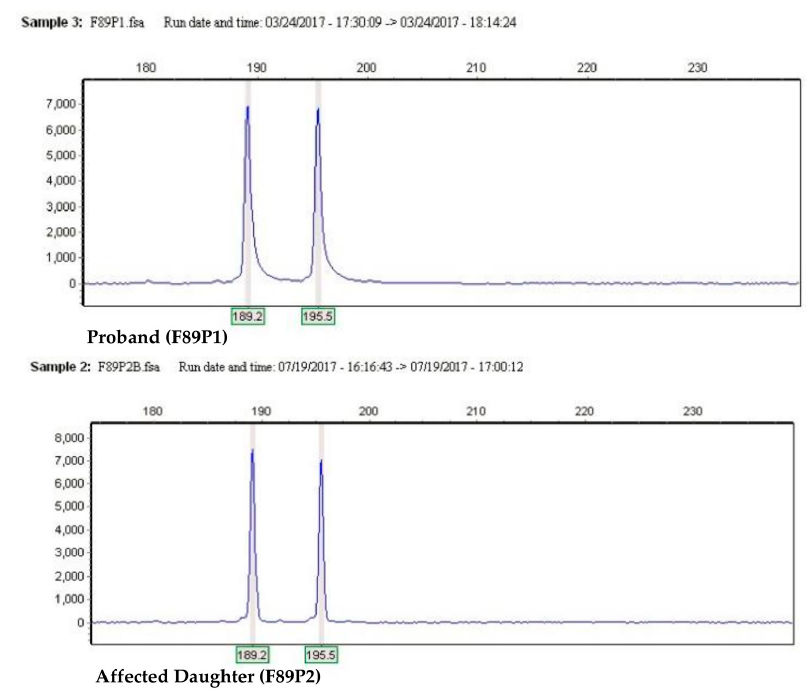
Figure A1. DNA fragment analysis by capillary electrophoresis. The image shows the double peaks of the two affected individuals from the same family (the index case and her daughter), meaning they were heterozygous carriers of the deletion. Note the 6 bp difference between the first peak (189 bp) and the second (195 bp) in both cases.